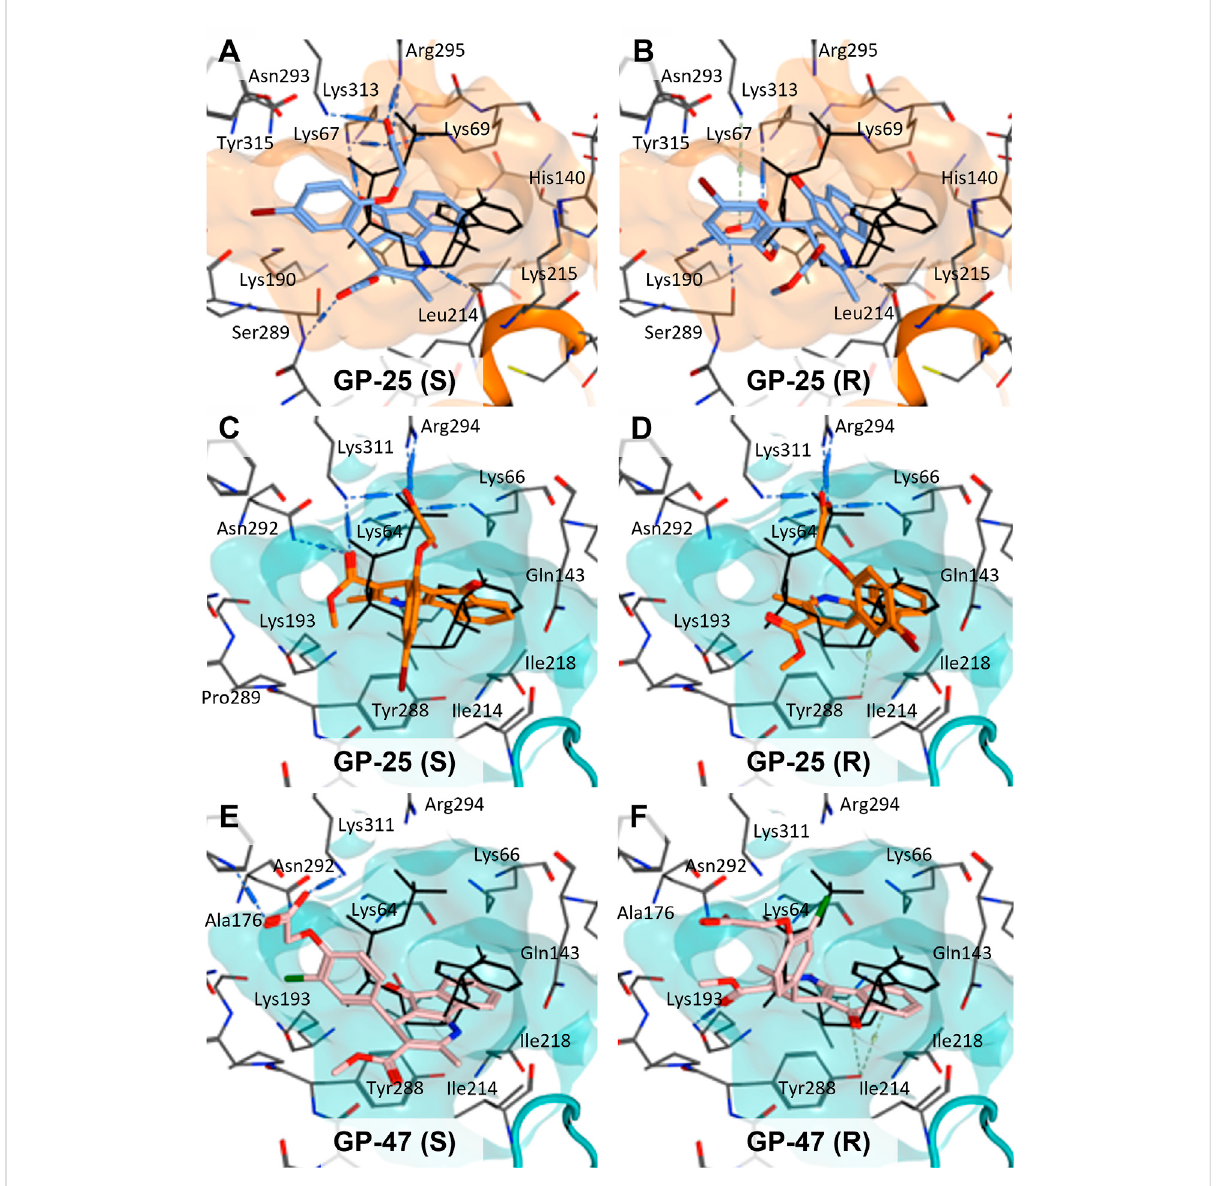
FIGURE 5 DockingofGP-25and GP-47intotheorthosteric pockets ofmolecular models ofhumanP2X4andratP2X7. (A,B) DockingofGP-25 (lilac) into human P2X4 (wheat). (C,D) Docking of GP-25 (orange) into human P2X7 (pale blue). (E,F) Docking of GP-47 (pale pink) into human P2X7 (pale blue). (A,C,E) represents the S-enantiomer and (B,D,F) represents the R-enantiomer. The ATP pose derived from the original crystal or cryoEM structure is shown in black lines for reference. Interactions are shown as dashed